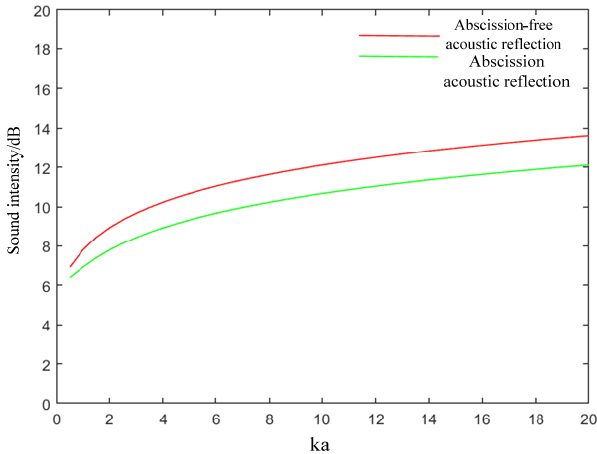
Figure 10. Acoustic intensity curve of underwater metal pipeline.